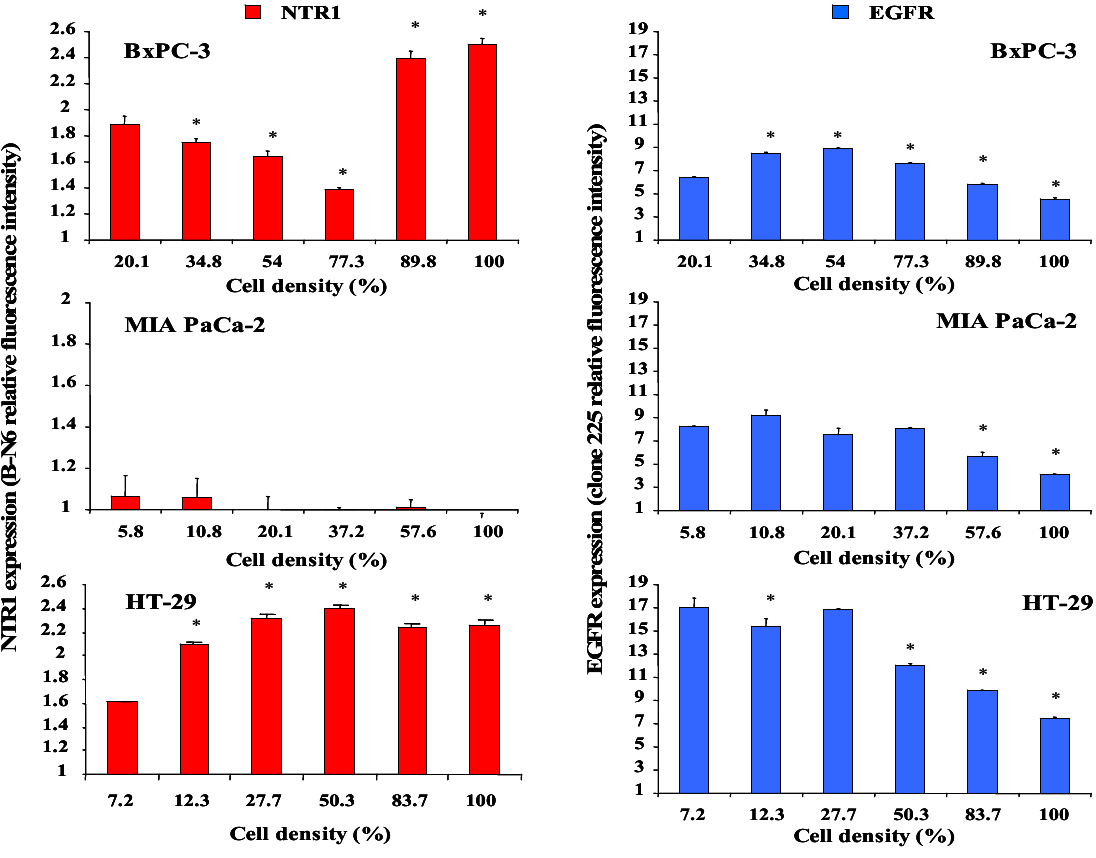
Figure 3. NTR1(left) and EGFR (right) expression of BxPC-3 (top), MIA PaCa-2 (middle) and HT-29 (bottom) cells in dependence of cell layer density determined by flow cytometry. Data are presented as mean ± SD of duplicate measurements (differences in expression to lowest density:* p <